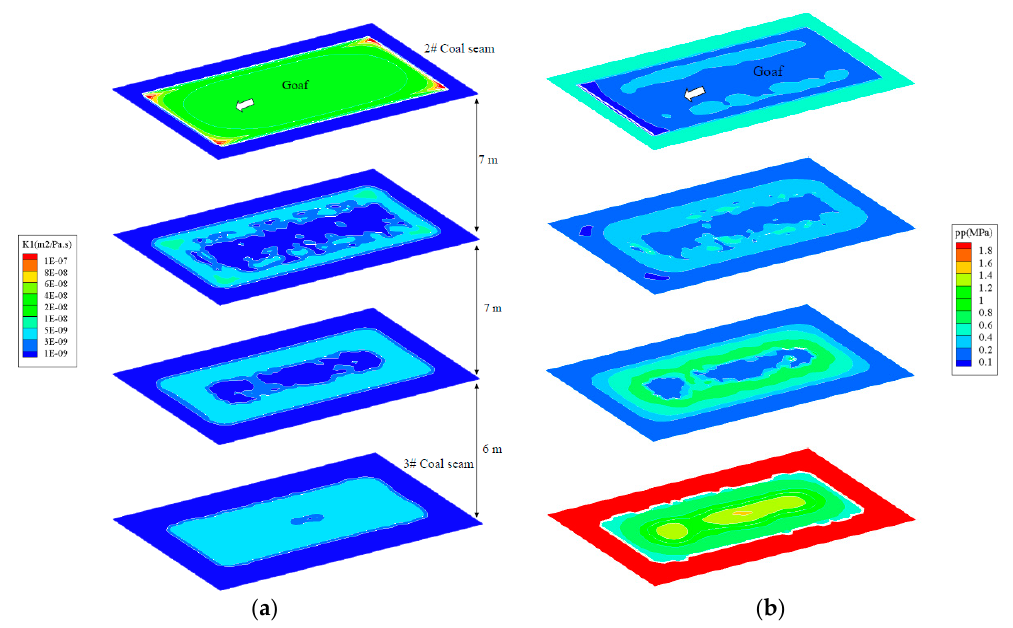
Figure 9. Cross-sectional diagram of gas permeability and gas pressure in different layer spacing between the protective seam and protected seam; ( a ) gas permeability, and ( b ) gas pressure.